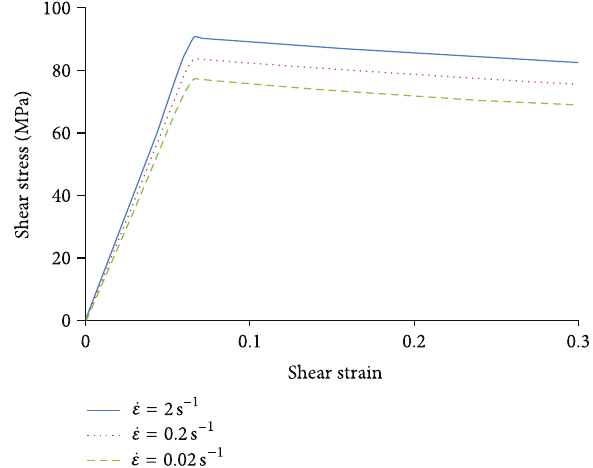
Figure 18: Shear stress-strain curves found by numerical simulation using the viscoelastic-viscoplastic